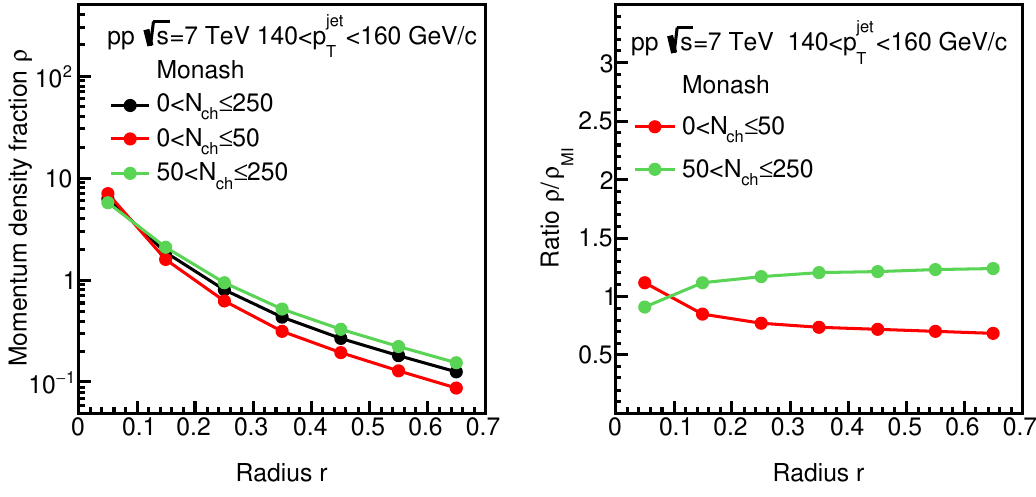
Figure 3. ( Left ) Differential jet shape for low- and high-multiplicity bins; ( Right ) The differential jet shape ρ divided by the ρ MI to emphasize the